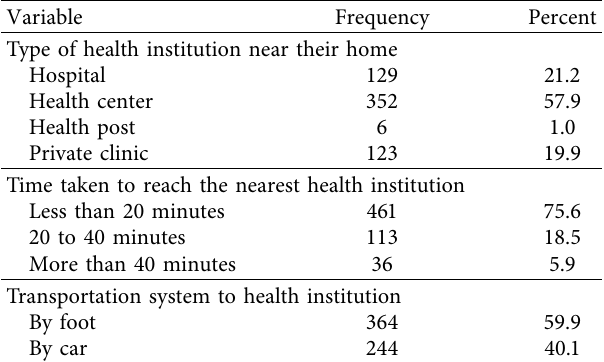
Table 2: Availability and accessibility of health care service for mothers in Dessie town, Ethiopia, 2020.